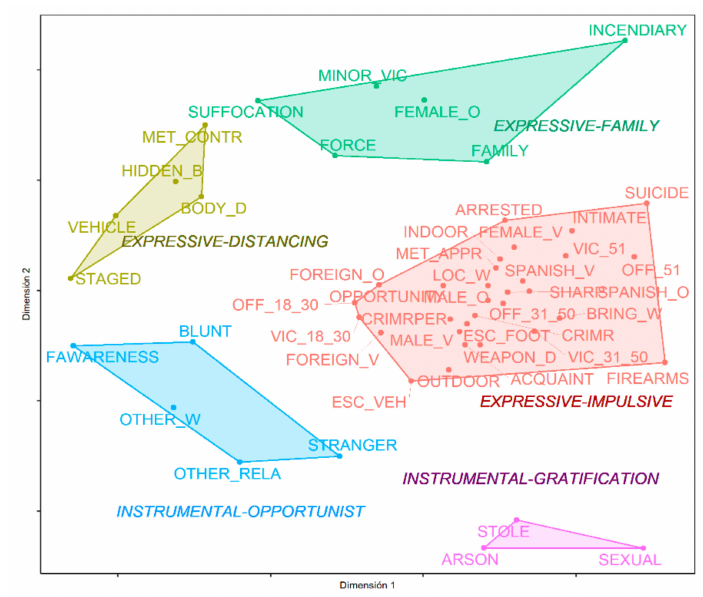
Figure 2. Simple homicide typology according to the instrumental / expressive